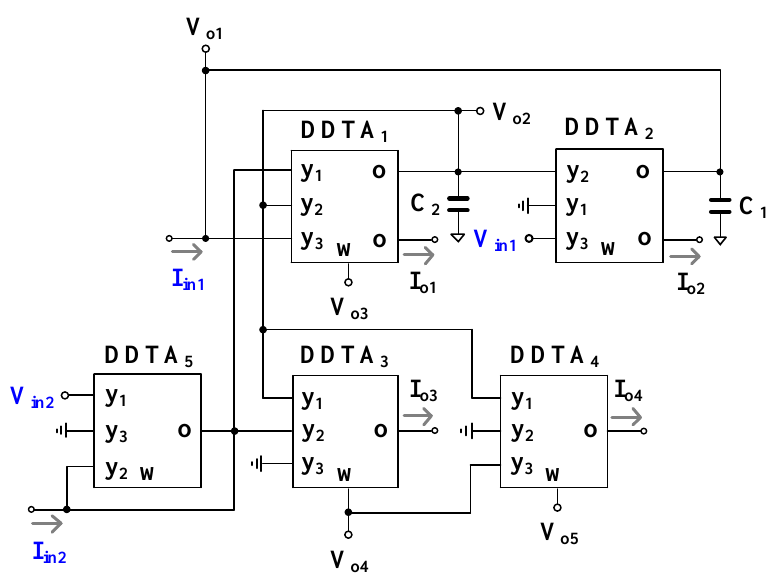
Figure 4. Proposed mixed-mode universal filter using DDTAs.